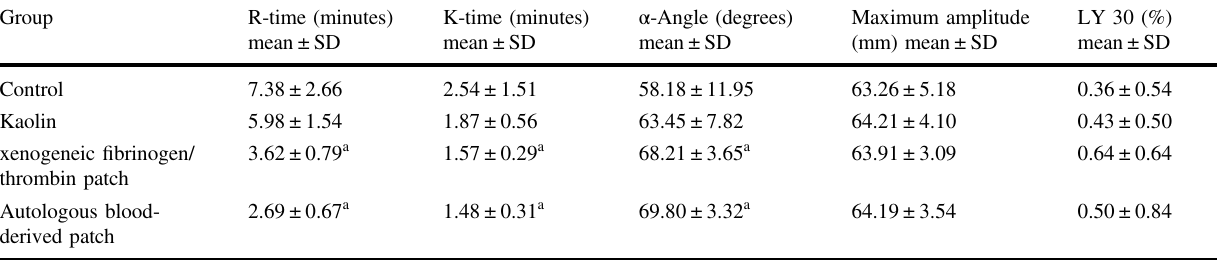
Table 1 Thromboelastography measurements on whole blood from 11 clinically healthy human donors